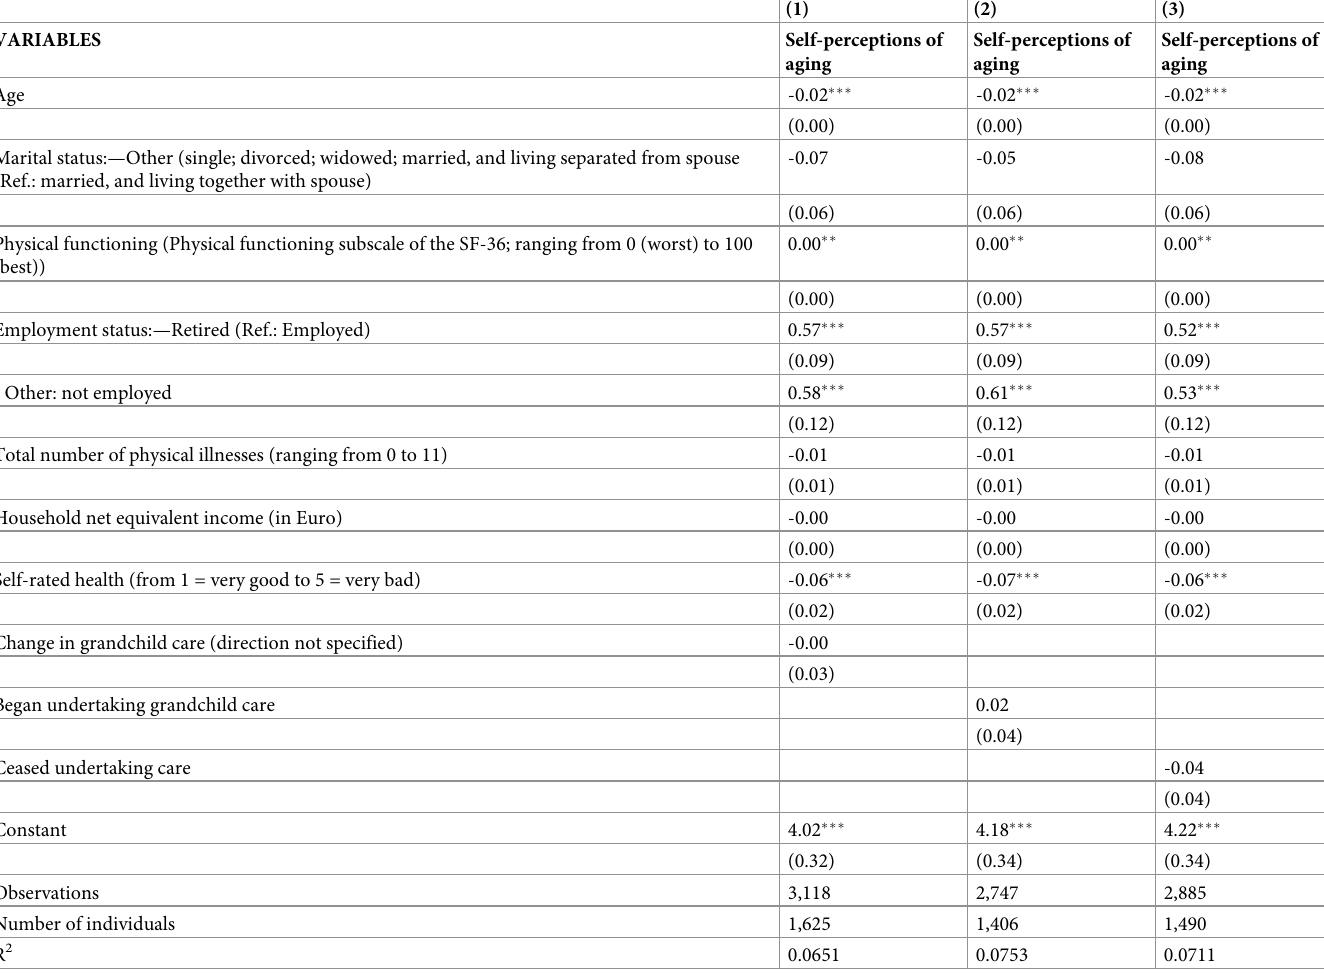
Table 2. Determinants of self-perceptions of aging. Results of fixed effects regressions (waves 4, 5 and wave